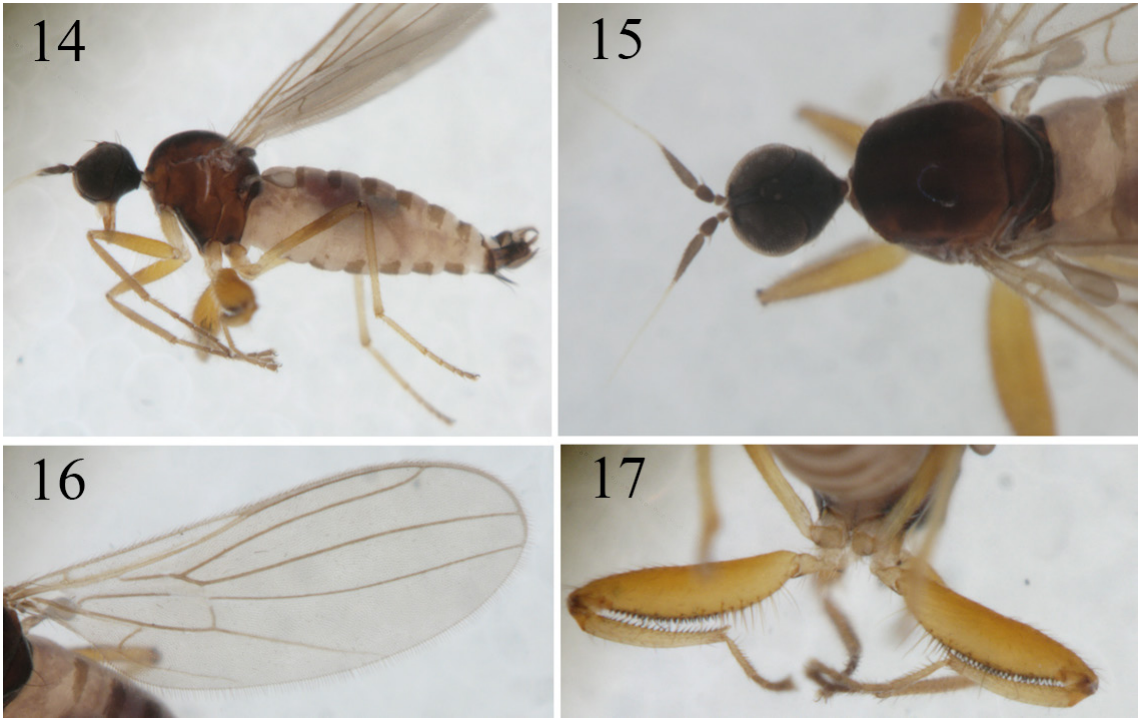
Figs 14–17. Platypalpus lokonda sp. nov., paratype ♂. 14 . Habitus, lateral view. 15 . Head and thorax, dorsal view. 16 . Wing. 17 . Mid legs, posterior